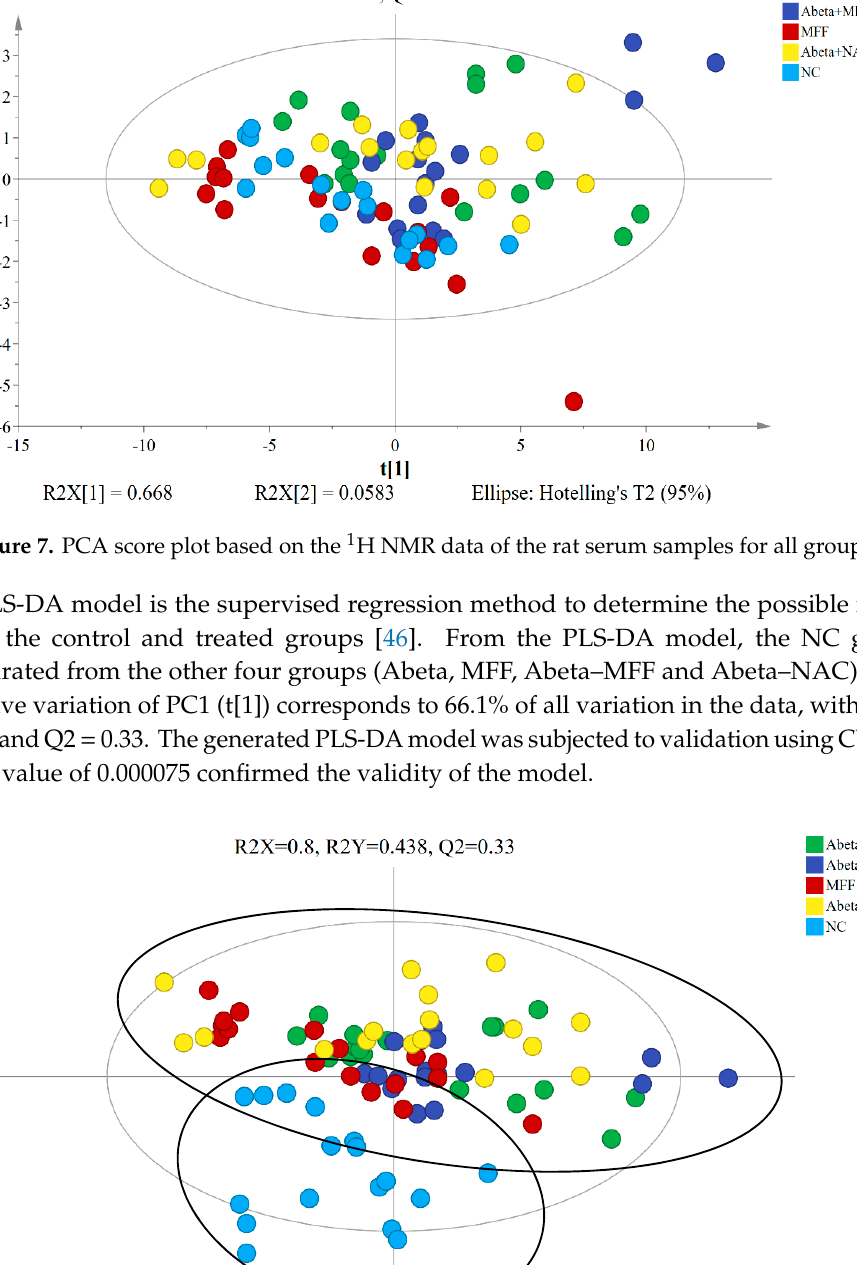
9 of 20 Figure 6. Overall 1 H NMR spectra of the rat serum samples obtained from all groups: (1) pantothenate, (2) leucine, (3) valine, (4) isoleucine, (5) isobutyrate, (6) 3-hydroxybutyrate, (7) lactate, (8) alanine, (9) acetate, (10) o-acetylcholine, (11) methionine, (12) acetone, (13) acetoacetate, (14) pyruvate, (15) succinate, (16) glutamine, (17) citrate, (18) n,n-dimethylglycine, (19) creatine, (20) malonate, (21)